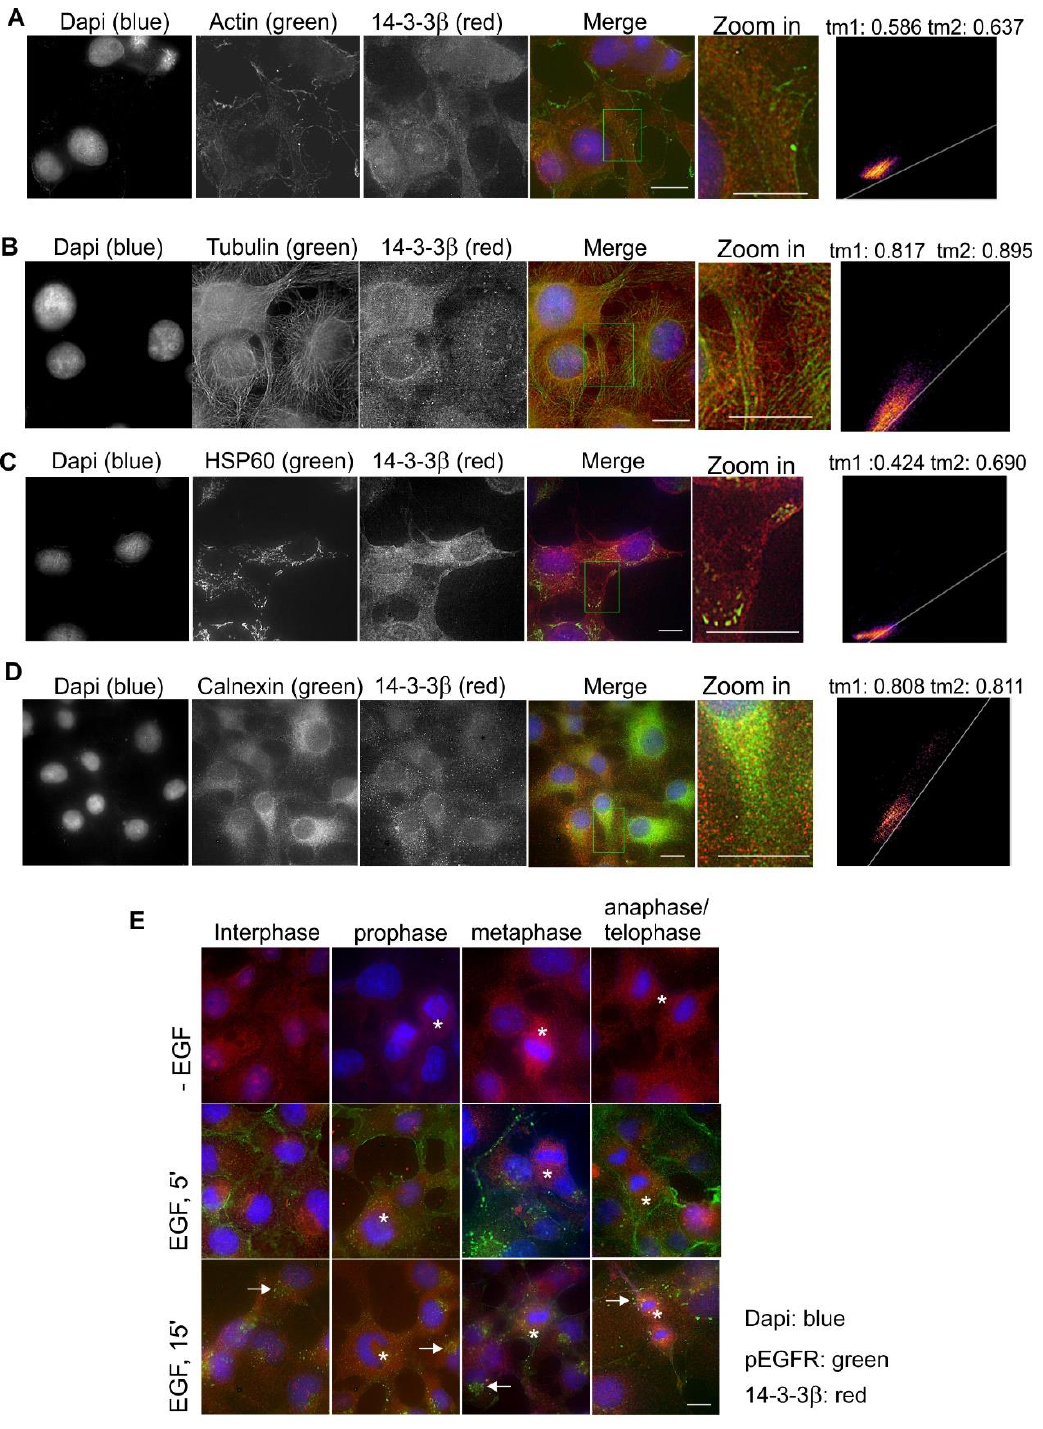
Figure 4. Subcellular localization of 14-3-3β in Cos-7 cells by double indirect immunofluorescence. ( A ) Co-localization of 14-3-3β (red) and actin (green); ( B ) co-localization of 14-3-3β (red) and tubulin (green); ( C ) co-localization of 14-3-3β (red) and HSP60 (green); ( D ) co-localization of 14-3-3β (red) and calnexin (green). For (A–D), the zoomed-in areas were used to calculate Mander’s coefficients. ( E ) Subcellular localization of 14-3-3β during the cell cycle and in response to EGF. With or without EGF stimulation, 14-3-3β (red) and pEGFR (green) were revealed by double indirect immunofluorescence. Mitotic cells are labeled by * and endosomes are marked by arrows. Scale bar = 10 μm.